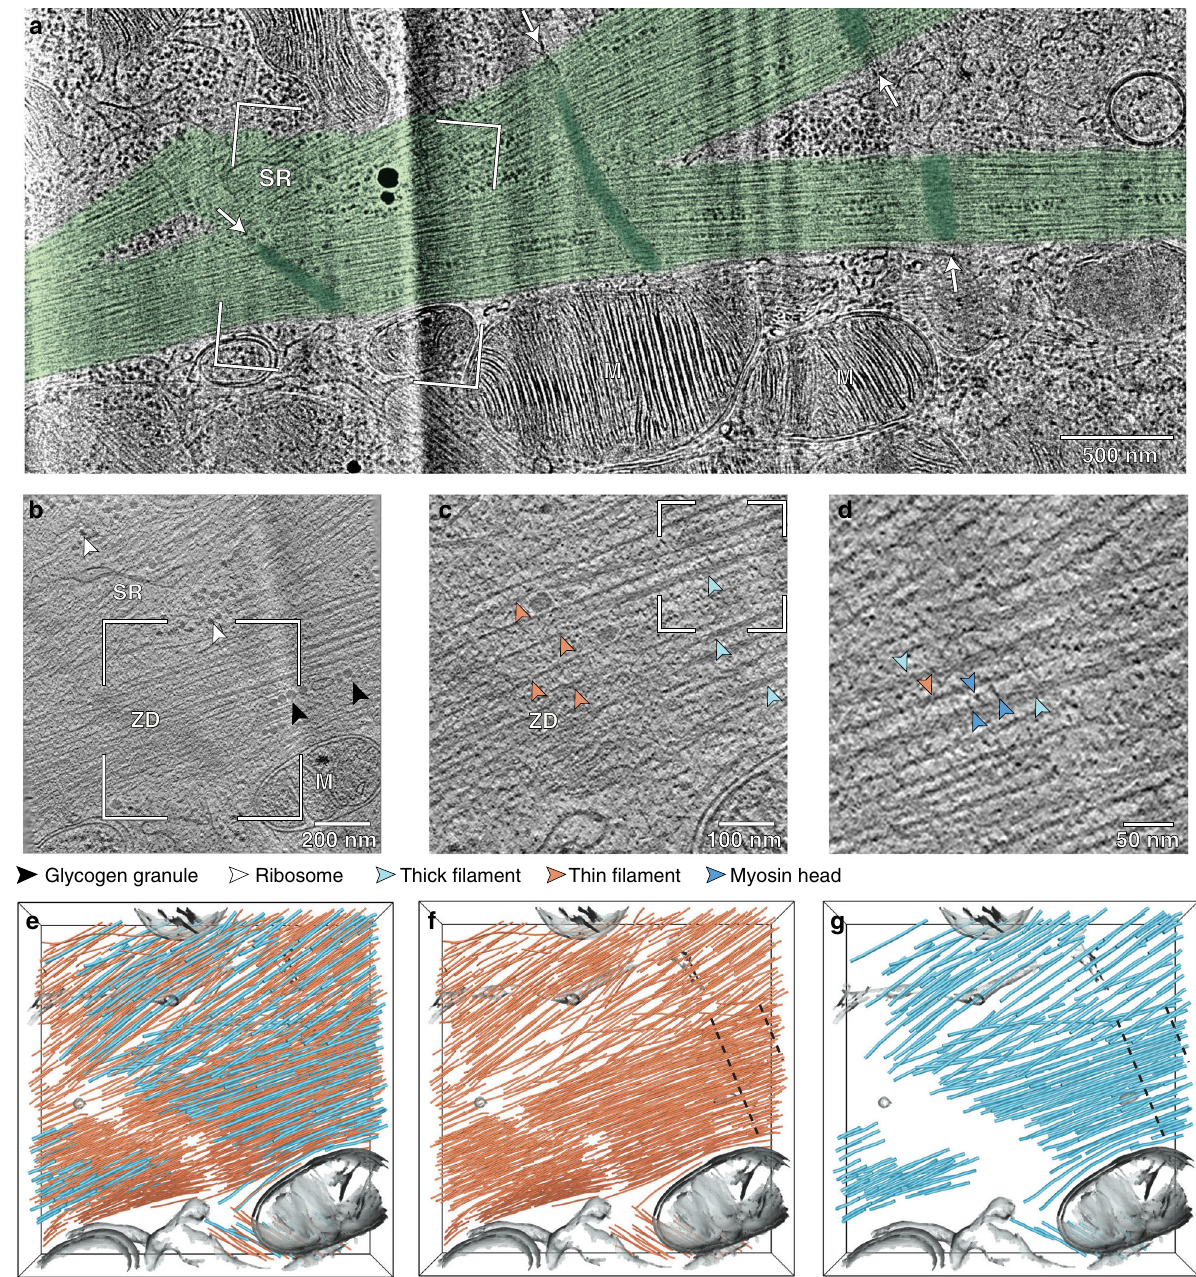
Fig. 2 Visualizing the myo fi brillar interior in situ. a TEM image of the enlarged framed area of a neonatal rat cardiomyocyte lamella shown in Supplementary Fig. 2d. Myo fi brils (green) display periodic, electron-dense lines (dark green, white arrows) aligned transversally with those of their neighbors, even after branching. M mitochondrion, SR sarcoplasmic reticulum. b 6.84 nm-thick slice from a defocused tomographic volume acquired at the framed area in a showing the myo fi brillar architecture. ZD Z-disk. Ribosomes and glycogen granules are indicated by white and black arrowheads, respectively. The tomogram has been rotated by 90° so that the TEM and tomographic images have the same orientation. The original tomogram has been deposited in the EMDB under accession code EMD-12572. c Zoomed-in view of the framed area in b showing a zig-zag- shaped Z-disk intersecting with thin fi laments (orange arrowheads) in the absence of thick fi laments (cyan arrowheads). d Zoomed-in view of the framed area in c showing myosin heads (dark blue arrowheads) bridging the myo fi laments. e – g 3D rendering of the cellular volume shown in b revealing the nanoscale organization of thin (orange; e , f ) and thick (cyan; e , g ) fi laments within unperturbed sarcomeres. The putative myosin bare zone estimated for an average sarcomere length of 1.8 μ m is delineated by dashed black lines in f , g . See also Supplementary Movie 2. Additional examples are provided in Supplementary Fig. 3. A total of 13 tomograms acquired from eight cells were used in this study (Supplementary Table 1). Each cell is from two separate experiments in which four organisms were mixed and can therefore be considered as a biological replicate. Representative images are